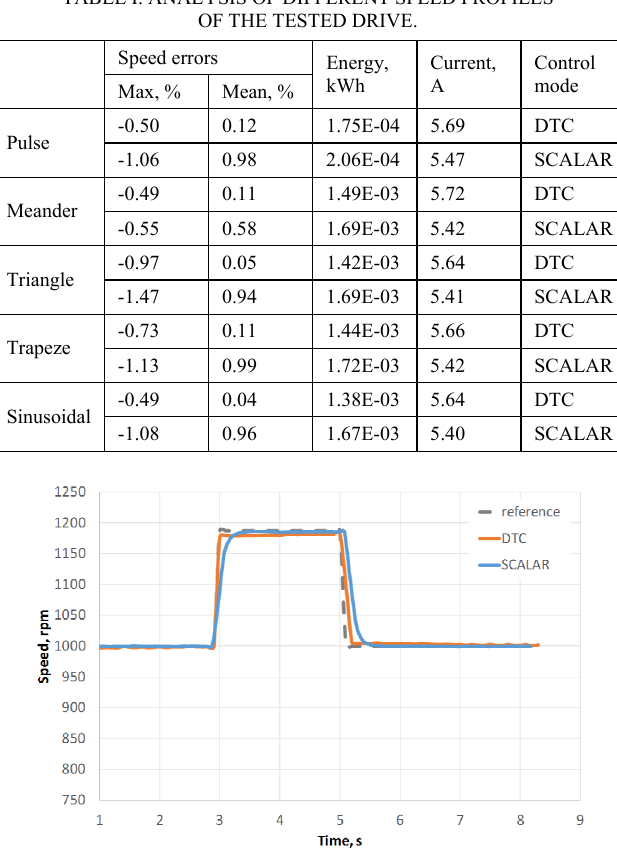
Fig. 6. Drive speed response profile around 1000 rpm at triangle test cycle.